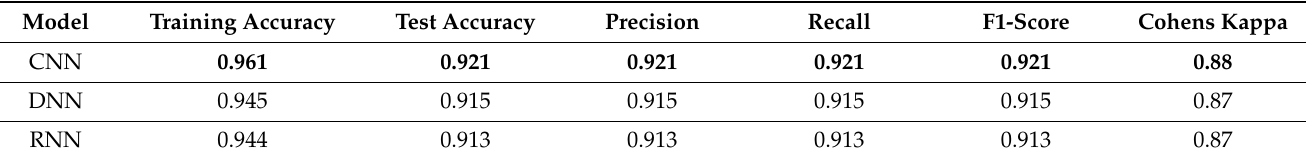
Table 7. Deep-learning model performances on training and test sets for six-class classification using all the features. The best performances are highlighted in bold.